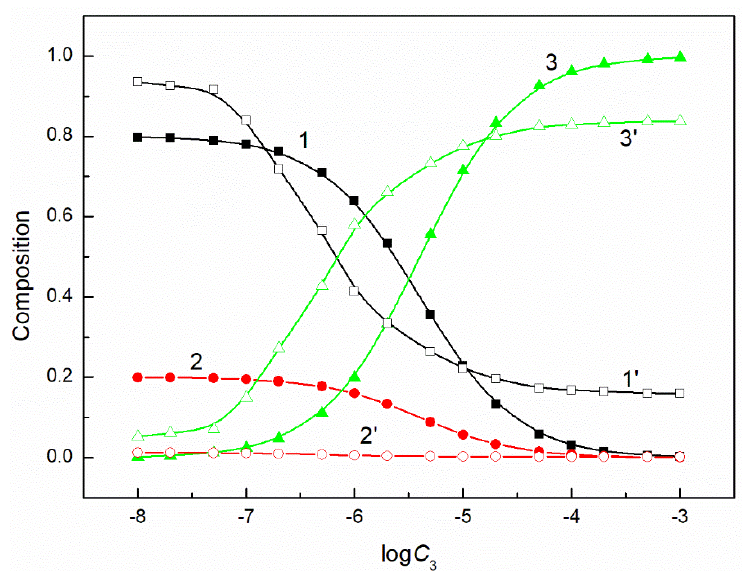
Figure 5. A plot of the composition of the ternary mixture including CTAB, TX100 and FC1 in the monolayer (curves 1–3) and in the bulk phase (curves 1’–3’) at the constant C 12 and γ LV = 60 mN/m vs. the logarithm of the FC1 concentration ( logC 3 ). Curves 1, 1’ correspond to CTAB, curves 2, 2’ correspond to TX100 and curves 3, 3’ to FC1.